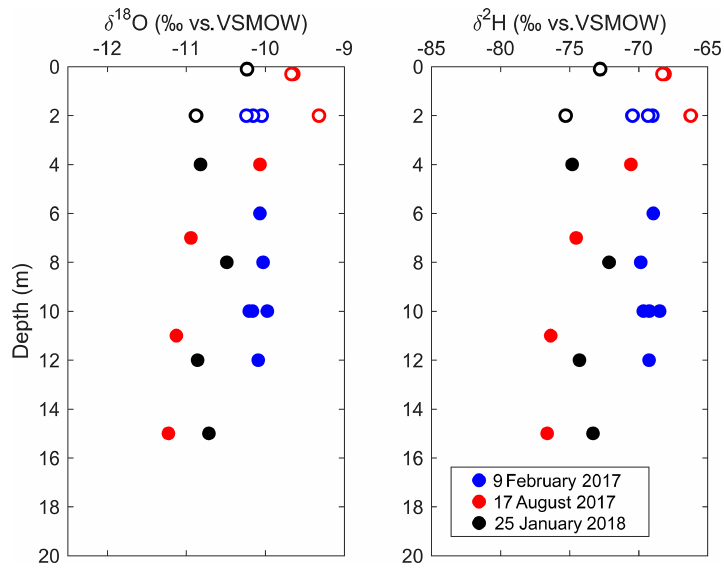
Figure E1. Isotopic composition of lake A water samples against depth on 9 February 2017, 17 August 2017, and 25 January 2018. The hollow circles and solid circles represent samples collected at ≤ 2 and > 2m depth,